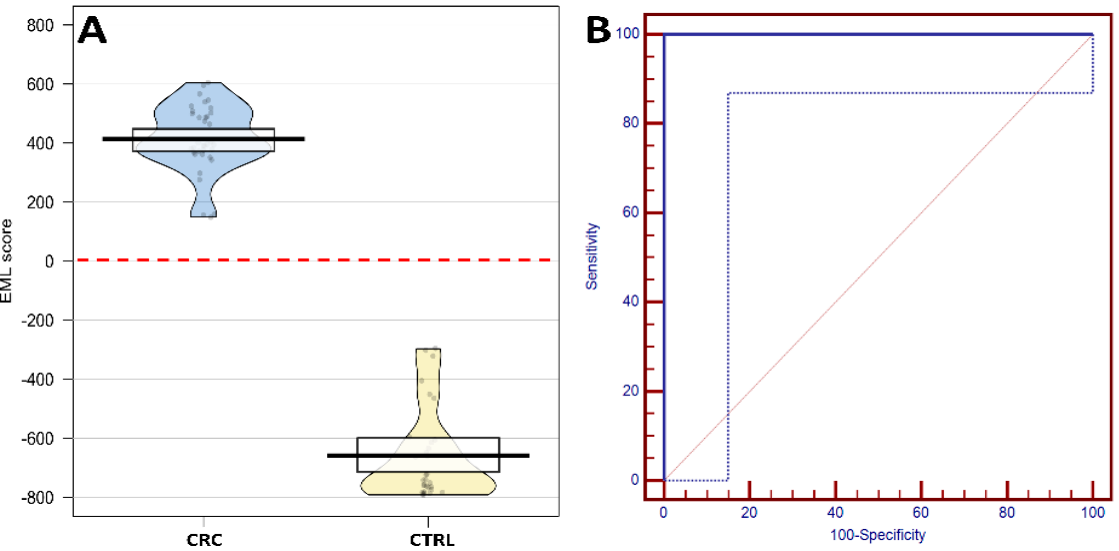
Figure 1. Ensemble machine learning (EML) scores calculated for the healthy controls (CTRL) and patients with colorectal cancer (CRC) among the test set; red dashed line represents the optimized cut-off value (Panel A ). Receiver operating characteristic (ROC) curve obtained by varying the cut-off value when applying the EML model to the test set (Panel B ); the area under the ROC curve is 1.0. Dotted blue line represents the 95% Confidence Bounds. Table 2. Performance metrics (value ± standard error) of the individual and the ensembled machine learning classification algorithms when applied to the test set. Abbreviations; NB: Naïve Bayes,